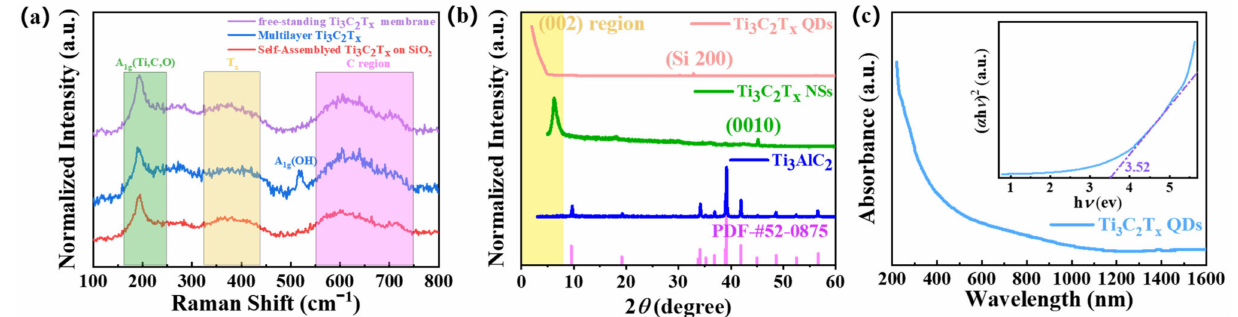
Figure 3. SPM images of Ti 3 C 2 T x NSs ( a ) and Ti 3 C 2 T x QDs ( b ), respectively.